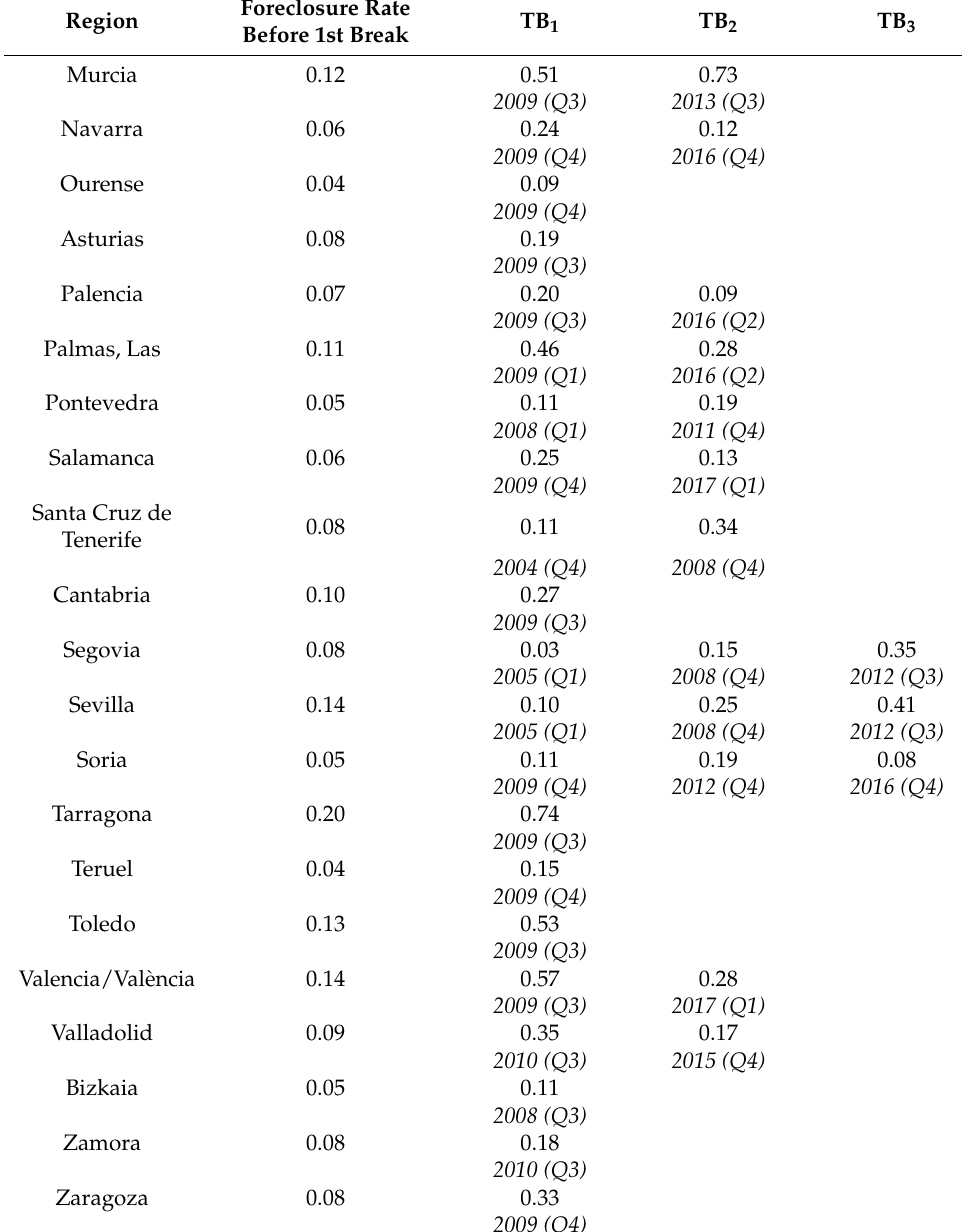
Table 5. Cont. Region